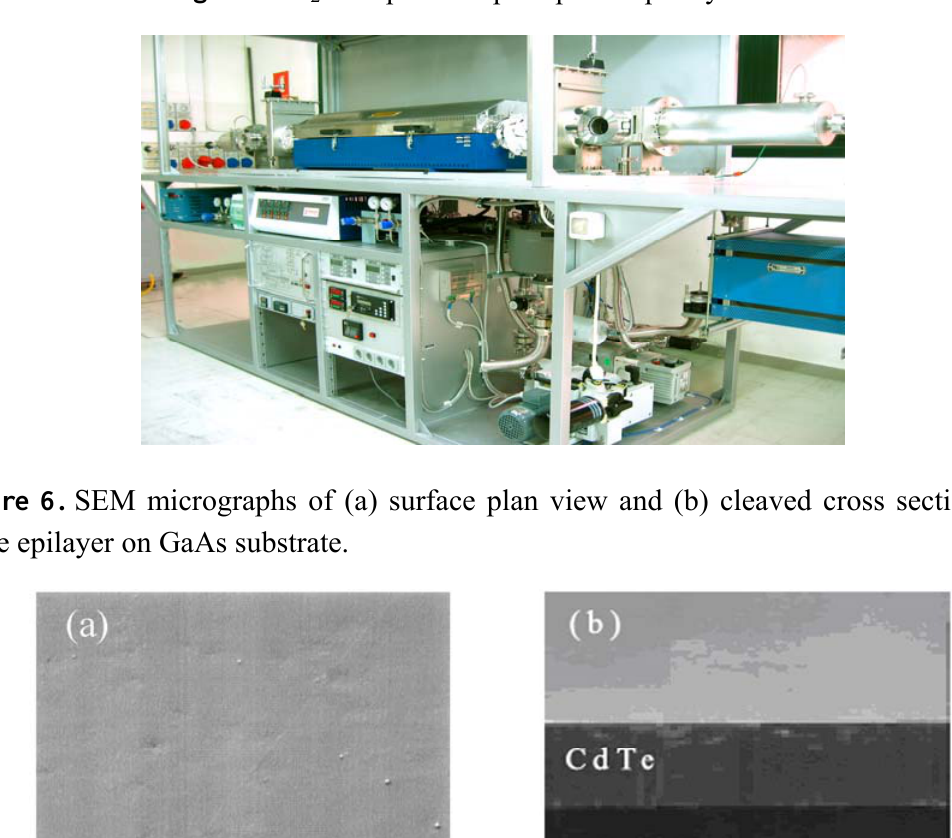
Figure 5. H transport – vapour phase epitaxy reactor. 2